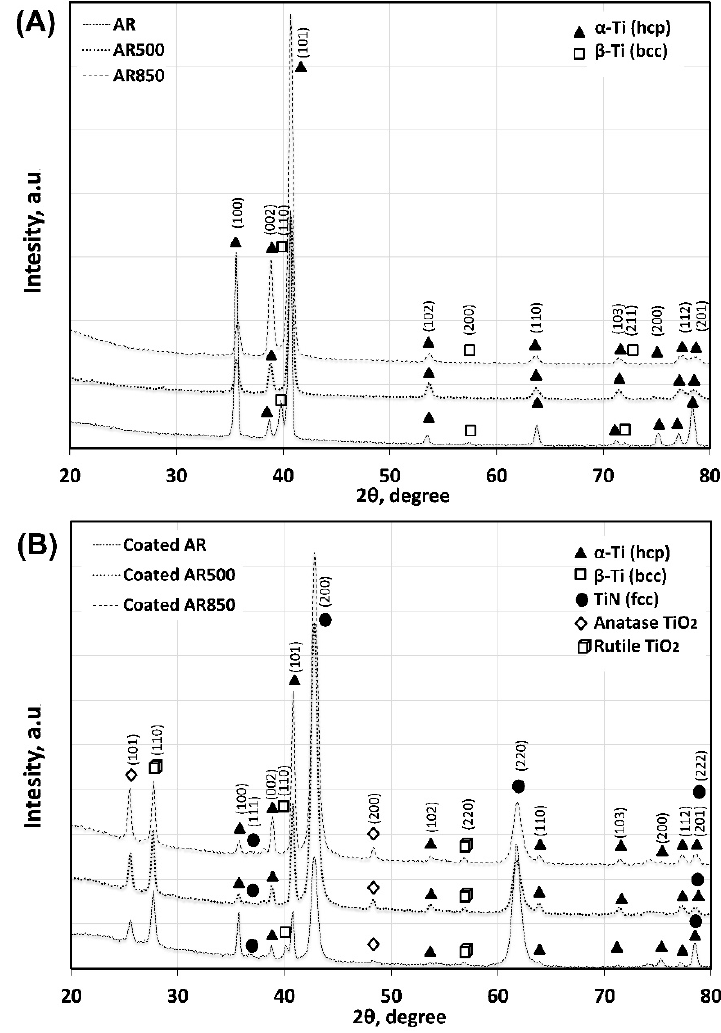
Figure 6. XRD spectra of the substrates ( A ) and deposited coating ( B